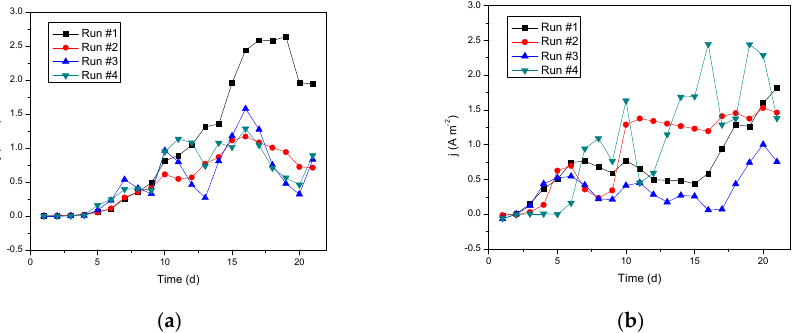
Figure 1. Current density versus time at ( a ) +0.34 V/SHE and ( b ) − 0.16 V/SHE polarization potential. Table 1. Maximum current density recorded at +0.34 V/SHE and − 0.16 V/SHE polarization potentials. Polarization Potential